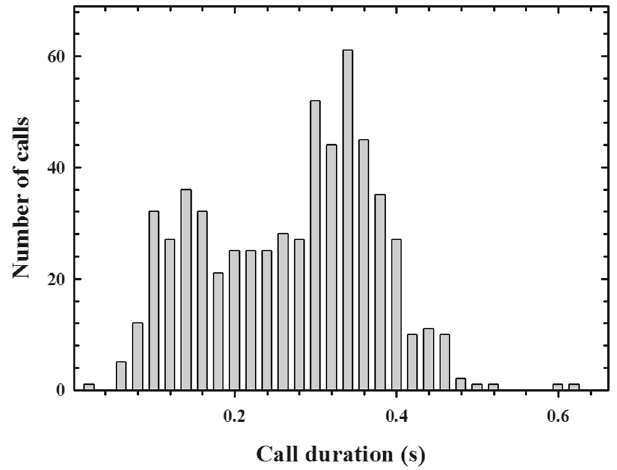
Figure 2. Histogram of note duration of recorded offshore calls (n = 597). The bin size is 0.02 seconds.